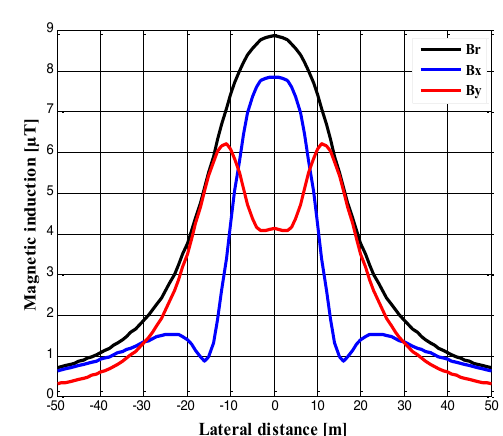
Figure 9: Magnetic induction profile with its components at mid-span length at 1 m above ground level. point (ground clearance) is less than that of the conductors at the end of span length (pylon foot), the magnetic induction profile above ground level follows a nearly Gaussian shape.